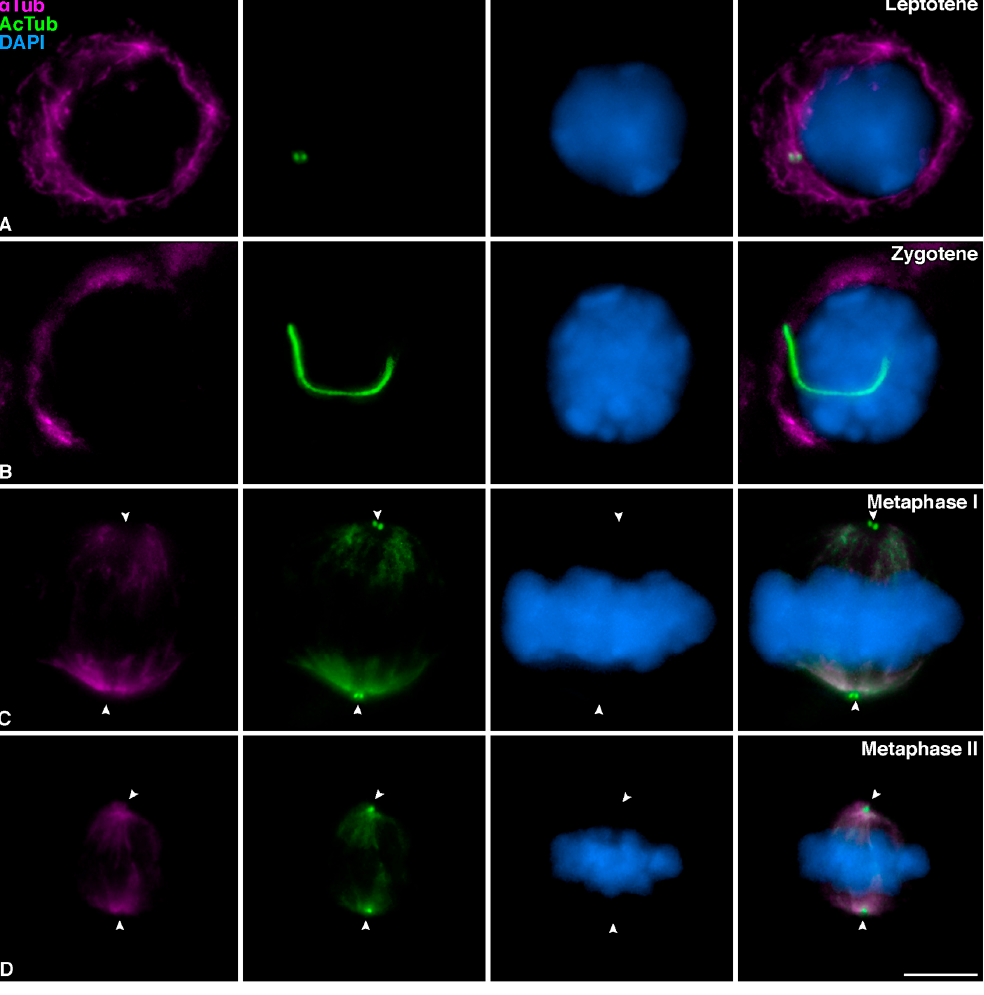
Figure 3. Study of the comparison between acetylated tubulin and non-acetylated tubulin in mouse spermatocytes. Double immunolabelling of α tubulin ( α Tub) (magenta) and acetylated tubulin (AcTub) (green), with chromatin stained with DAPI (blue) on squashed WT mouse spermatocytes at ( A ) Leptotene, (B) Zygotene with primary cilium, ( C ) Metaphase I, and ( D ) Metaphase II. White arrowheads in ( C , D ) indicate centrosomes localization. Scale bar in ( D ) represents 5 µm.